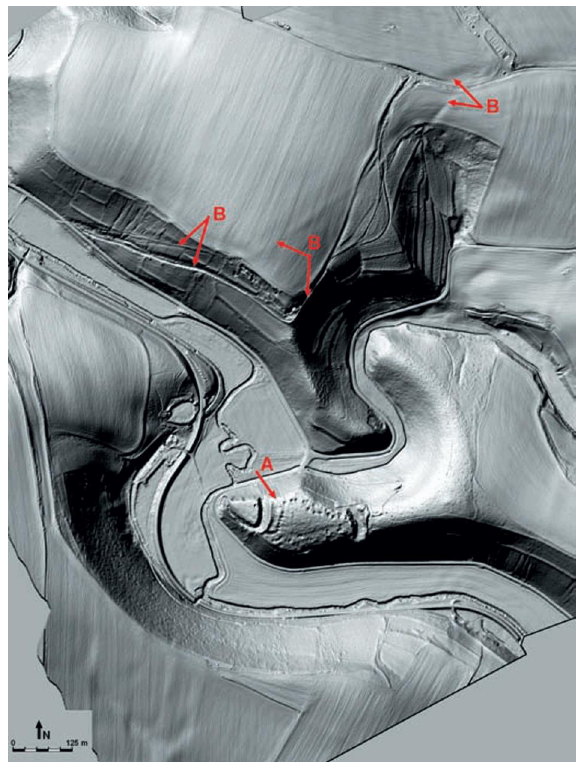
Figure 1. Radkov (A) on the historic route of the Moravian Třebová - Mohelnice /Líšnice